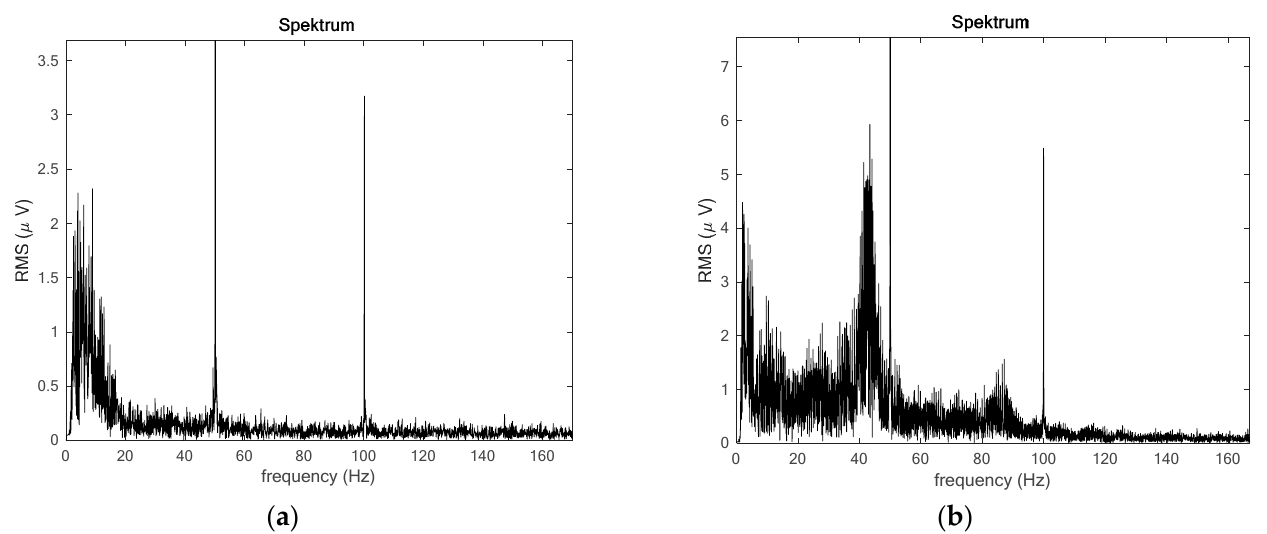
Figure 4. Example of the zoomed spectrum ( a ) ECG signal with high impact of environmental disturbances. 3rd order Butterworth HP filter, f c = 2 Hz, ( b ) superimposed EMG and ECG signals with high impact of environmental disturbances.